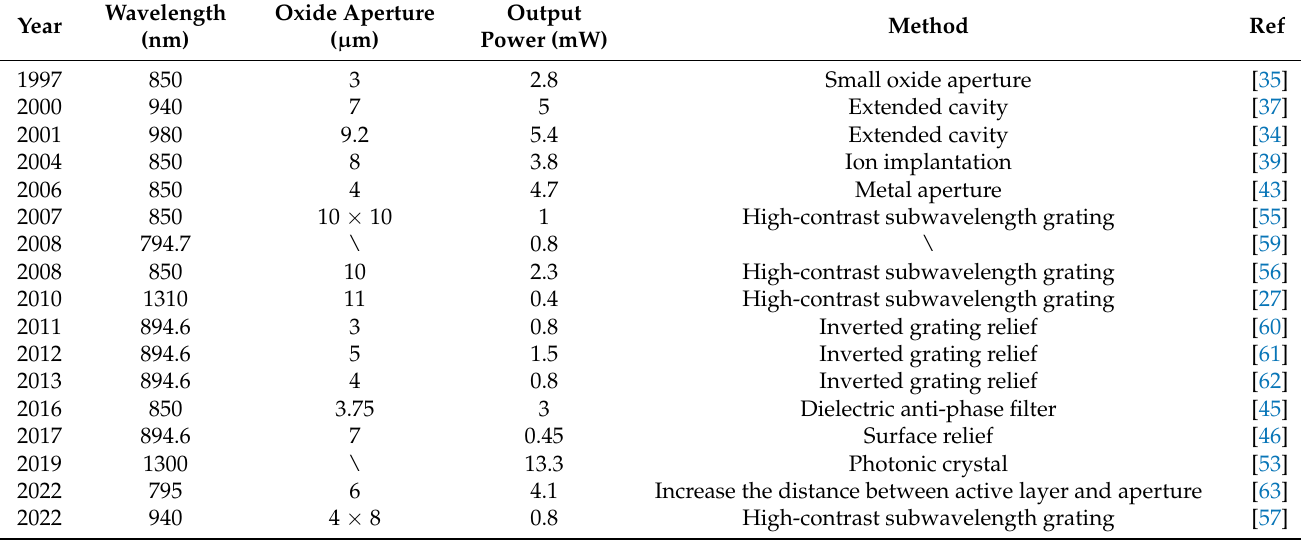
Table 1. Research progress of single-mode control method of